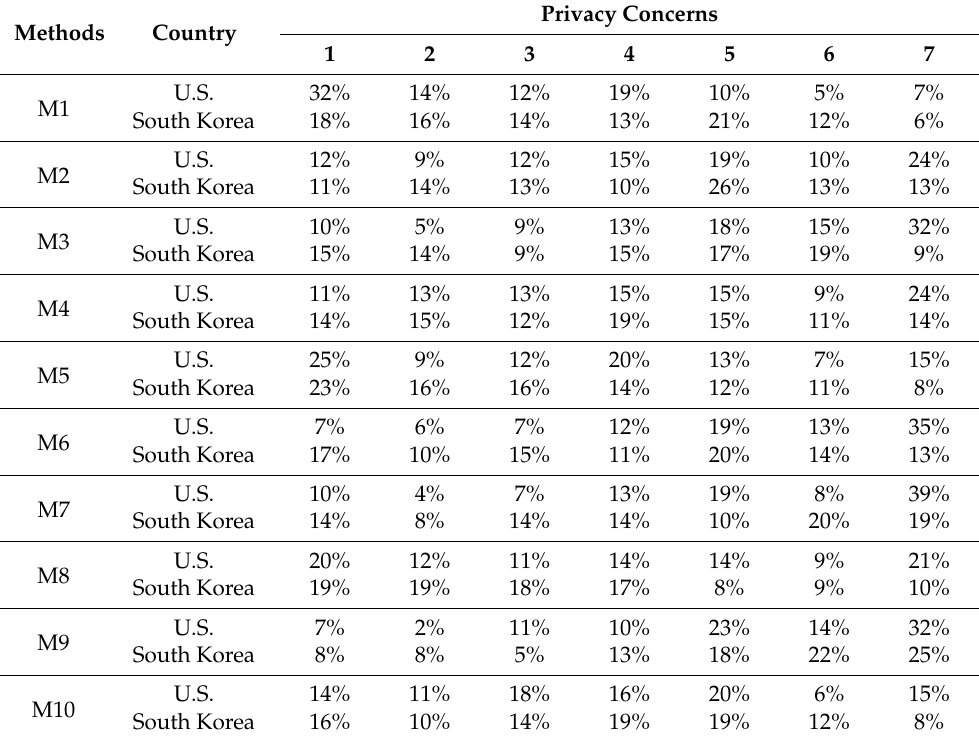
Table A2. Frequency of the privacy concerns for 10 methods (U.S. and South Korea). Methods Country